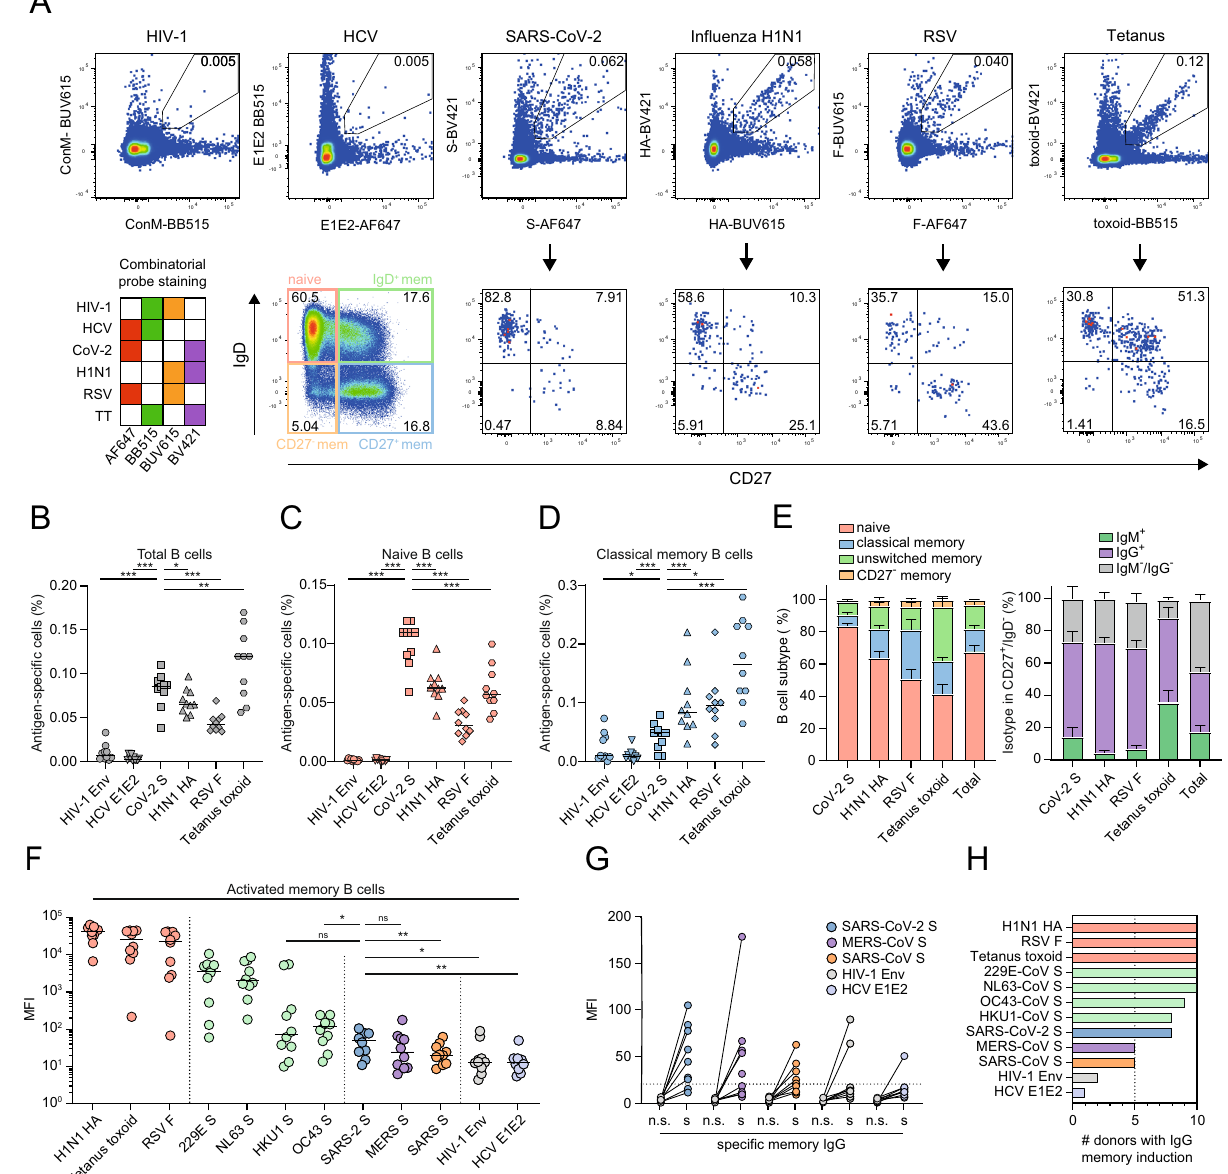
Fig. 1 | Phenotypic characterization of SARS-CoV-2 S-reactive B cells in unex- posed individuals. A Combinatorial probe staining and gating strategy for the detection of multiple B cell speci fi cities in a single PBMC sample. Top panel: From live B cells (gating strategy Fig. S1), antigen-reactive B cells are detected as doublepositiveforthebindingofthesameantigenmultimerizedwithtwodifferent fl uorochromes. Bottom panel left, matrix depicting each combination of two fl uorochrome-coded to the same antigen. Bottom panel left, B cell subsets were determined from antigen-reactive B cells according IgD and CD27 expression (IgD + /CD27 − , naive; IgD + /CD27 + , unswitched IgD + memory; IgD − /CD27 − , CD27 − memory; IgD − /CD27 + , classical memory). The numbers inside the boxes represent thefrequency(%)ofcellsinagate. B – D Frequencyofantigen-reactiveBcellsforten HDs (Statistical differences were tested only in comparison to SARS-CoV-2 condi- tion( N =10,median)intotalBcells( B ),naiveBcells(IgD + /CD27 − ,( C ),ormemoryB cells (IgD − /CD27 + , ( D ). Each dot represents one individual HD. The line represents